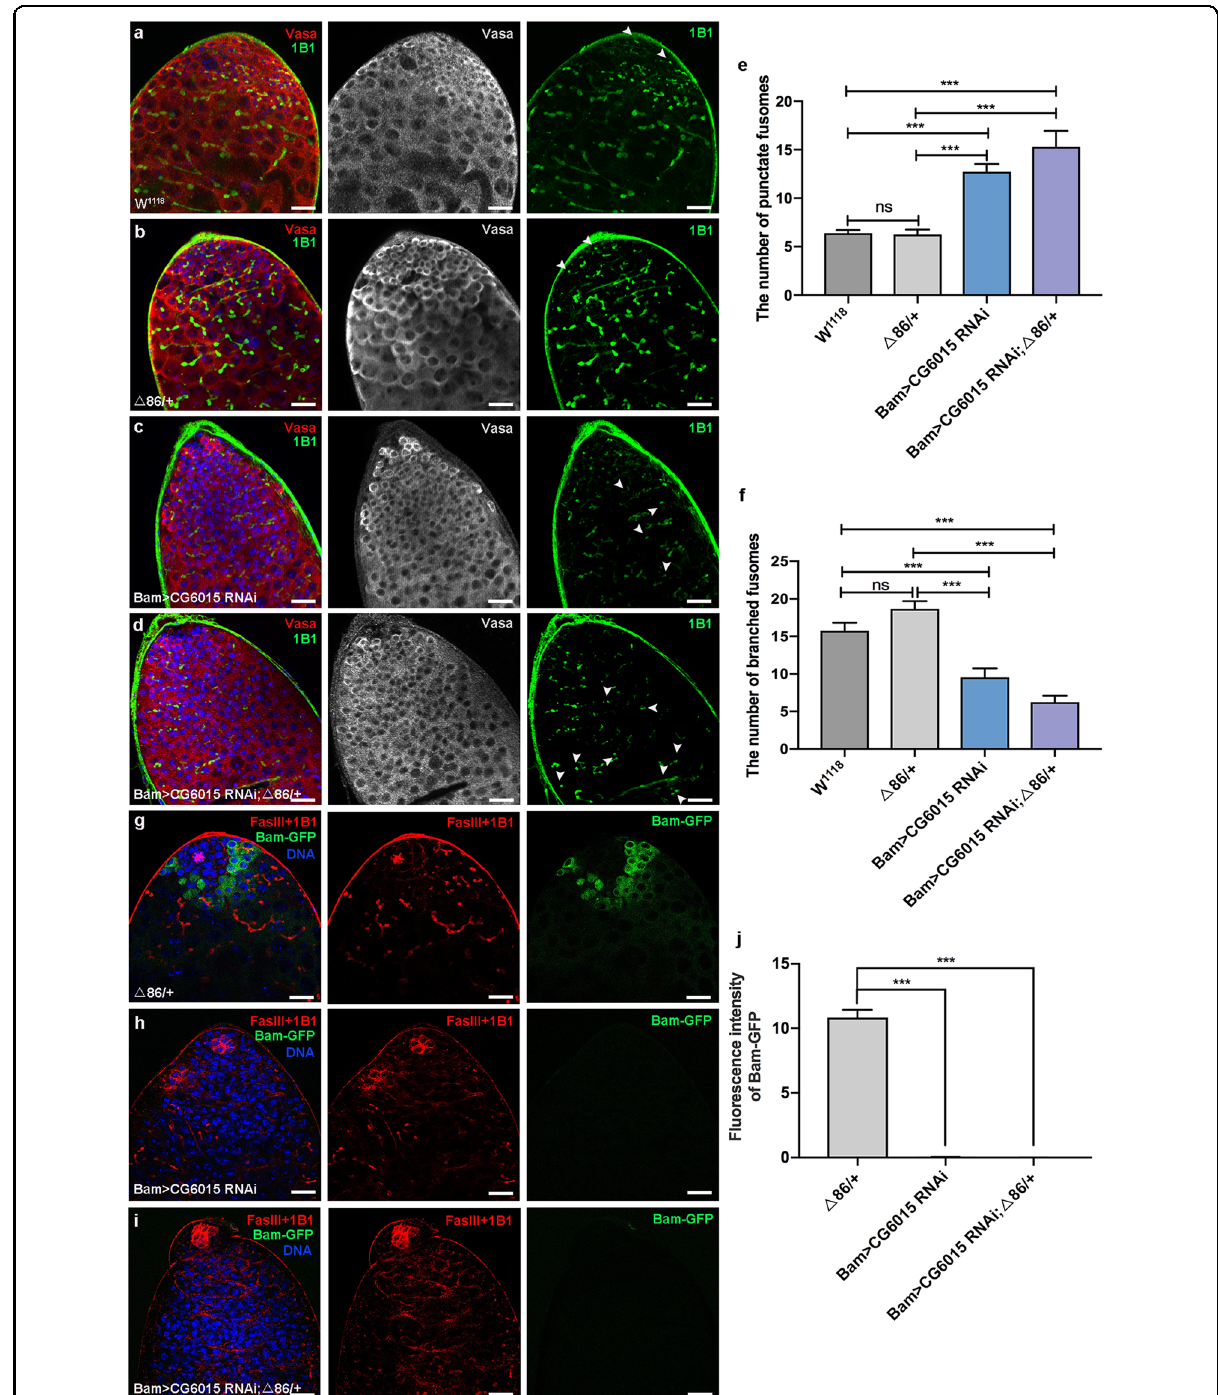
Fig. 2 Reduction of CG6015 in spermatogonia restrained germline differentiation. a – d Immunostaining of Vasa (red) and 1B1 (green) at the apex of W 1118 , Δ 86/ + , Bam> CG6015 RNAi and Bam> CG6015 RNAi; Δ 86/ + testes. e The number of punctate fusomes (also de fi ned as ‘ unbranched fusomes ’ among germ cells) at the apex of W 1118 ( n = 13), Δ 86/ + ( n = 12), Bam> CG6015 RNAi ( n = 11) and Bam> CG6015 RNAi; Δ 86/ + ( n = 13) testes. f The number of branched fusomes at the apex of W 1118 ( n = 13), Δ 86/ + ( n = 12), Bam> CG6015 RNAi ( n = 11) and Bam> CG6015 RNAi; Δ 86/ + ( n = 13) testes. g – i Immunostaining of FasIII (red), 1B1 (red) and Bam-GFP (green) at the apex of Δ 86/ + , Bam> CG6015 RNAi and Bam> CG6015 RNAi; Δ 86/ + testes. j Fluorescence intensity of Bam-GFP at the apex of Δ 86/ + ( n = 15), Bam> CG6015 RNAi ( n = 3) and Bam> CG6015 RNAi; Δ 86/ + ( n = 3) testes. DNA was stained with Hoechst (blue). *** P < 0.001, ns. not signi fi cant. Scale bars: 20